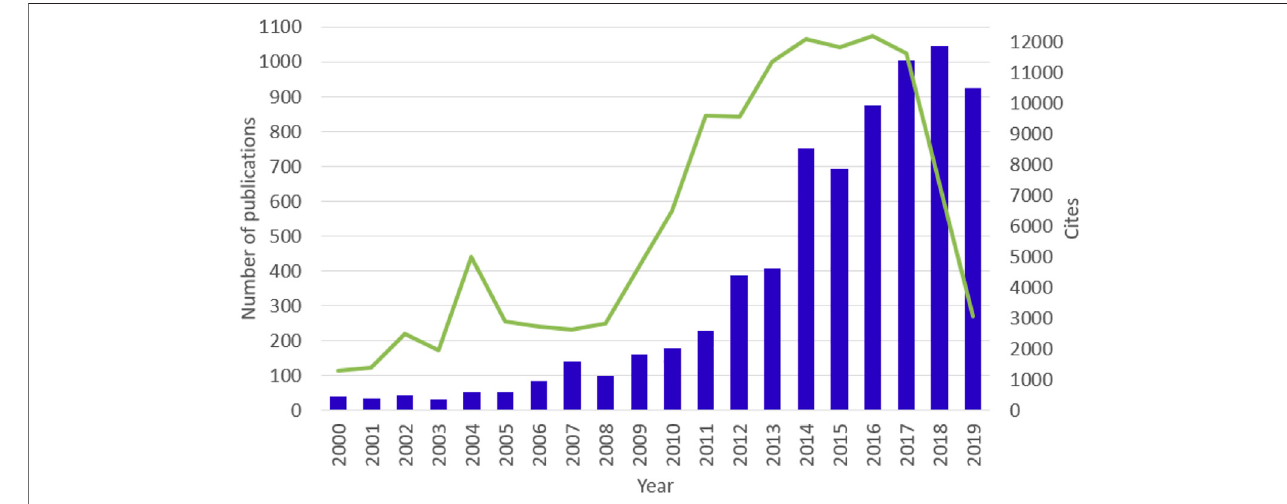
FIGURE 1 | CSP publications and citations during the last 2 decades.